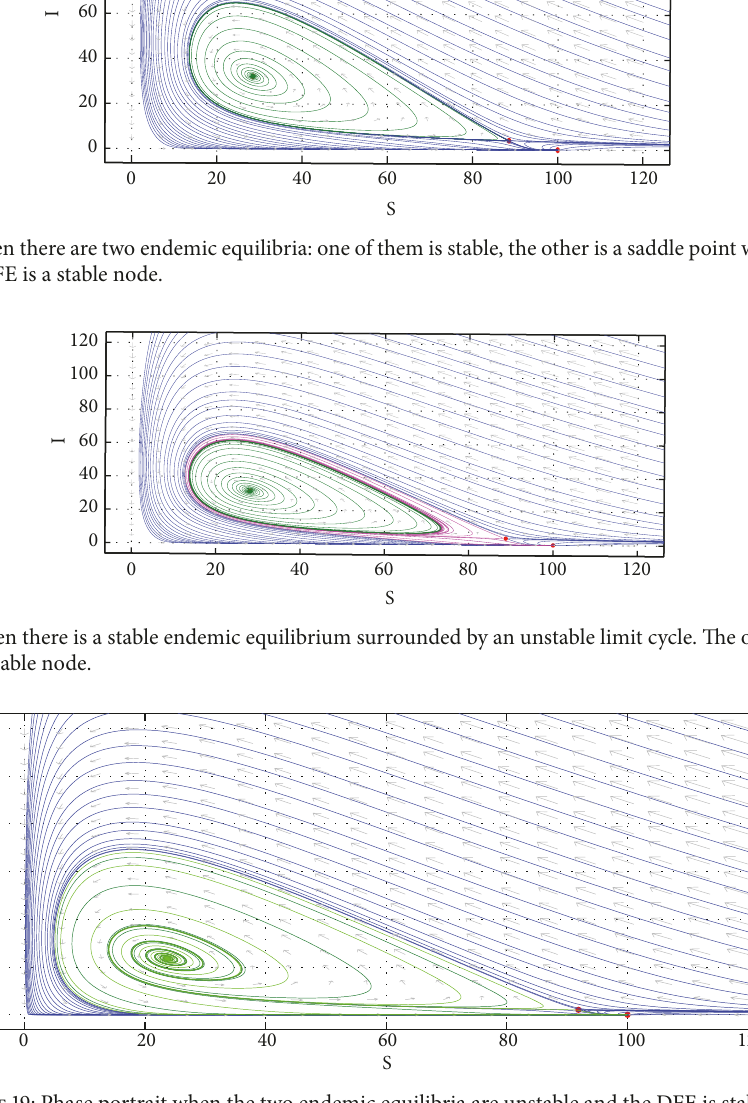
Figure 19: Phase portrait when the two endemic equilibria are unstable and the DFE is